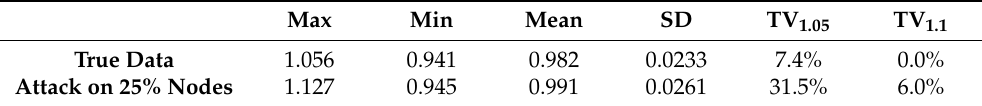
Table 1. Main results comparing average effects of 10 simulations with 25% of manipulated measure- ments and true data processed by VR